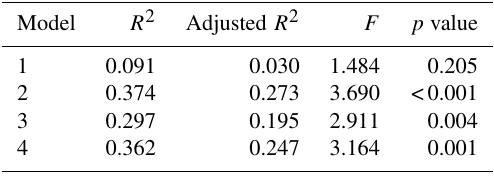
Table 2. Shows the results from multiple regressions.